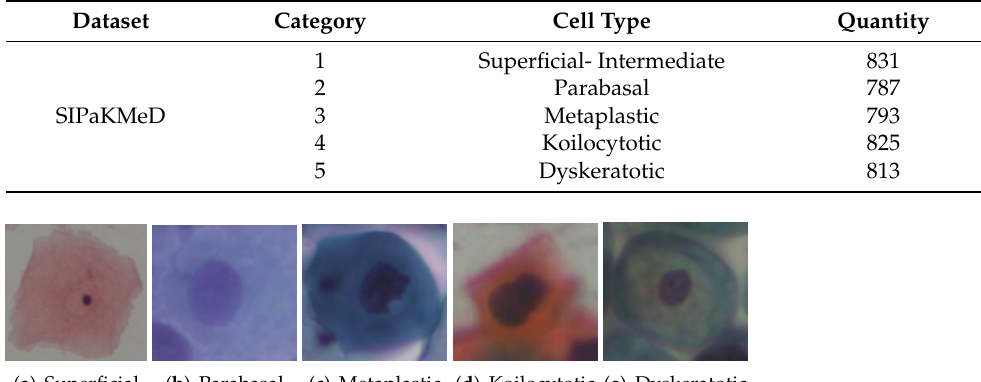
Figure 3. Examples of SIPaKMeD dataset